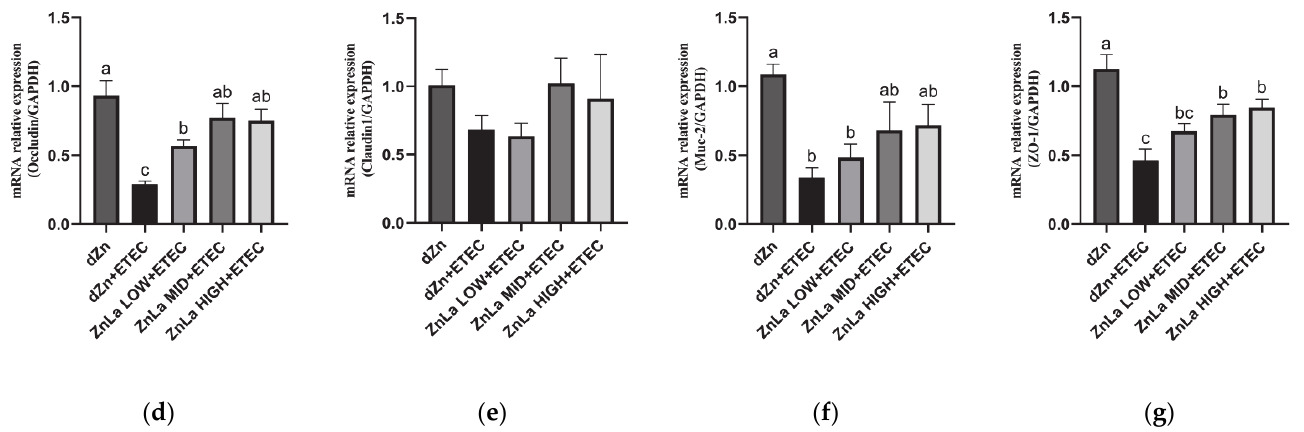
Figure 3. Effect of ZnLa on the intestinal barrier function of mice with ETEC challenge. Serum levels of ( a ) DAO, ( b ) DLA, and ( c ) Endotoxin. Relative mRNA expression of ( d ) Occludin , ( e ) Claudin ‐ 1 , ( f ) MUC ‐ 2 , and ( g ) ZO ‐ 1 in the jejunum. The data are expressed as mean ± s.e.m (n = 9), and different lowercase letters in each group show significant differences ( p < 0.05).